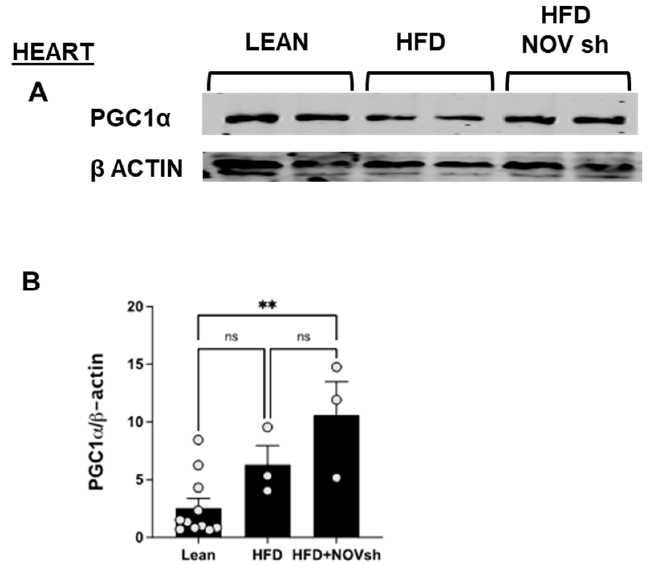
Figure 9. Improved expression of mitochondrial proteins in the heart of shNOV-treated mice (NOV knockdown). Representative western blots of PGC-1 α ( A , B ), and corresponding quantifications ( B ) in the heart of lean, high-fat, and shNOV. Results are means ± SE; ** p < 0.01, ns = not